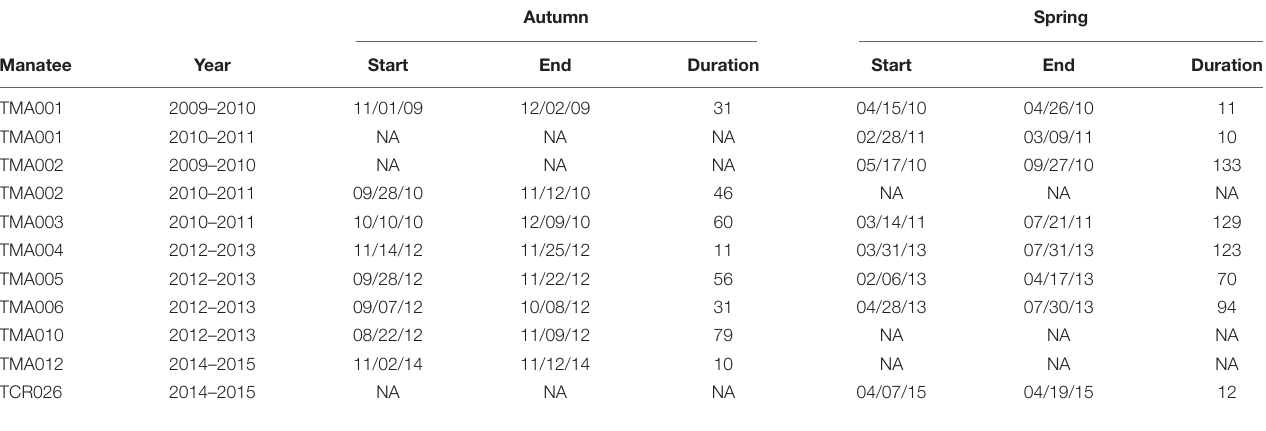
TABLE 2 | Start and end dates and duration (days) of manatee seasonal migrations between the northern Gulf of Mexico and peninsular